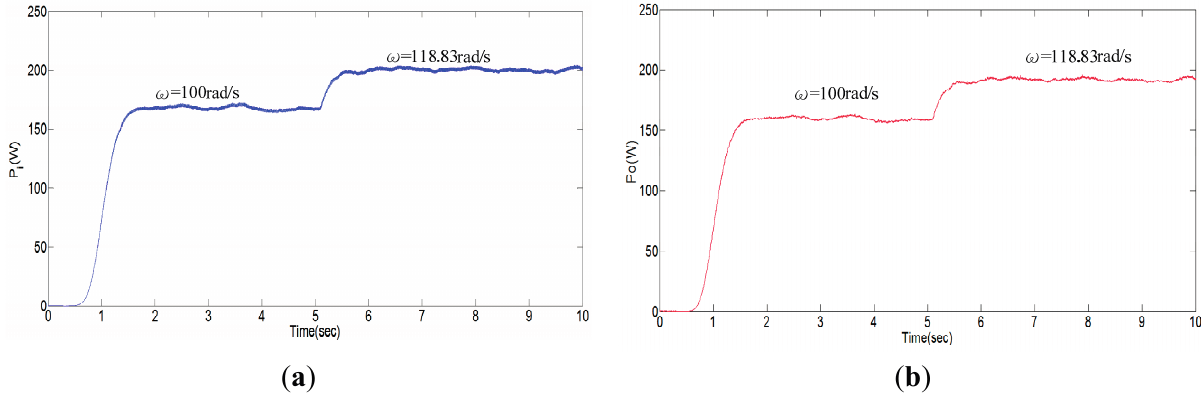
Figure 16. Stability and robustness verify at speeds from ω = 100 rad/s to ω = 118.83 rad/s with white noise: ( a ) Boost converter input power (Pi); ( b ) Boost converter output power